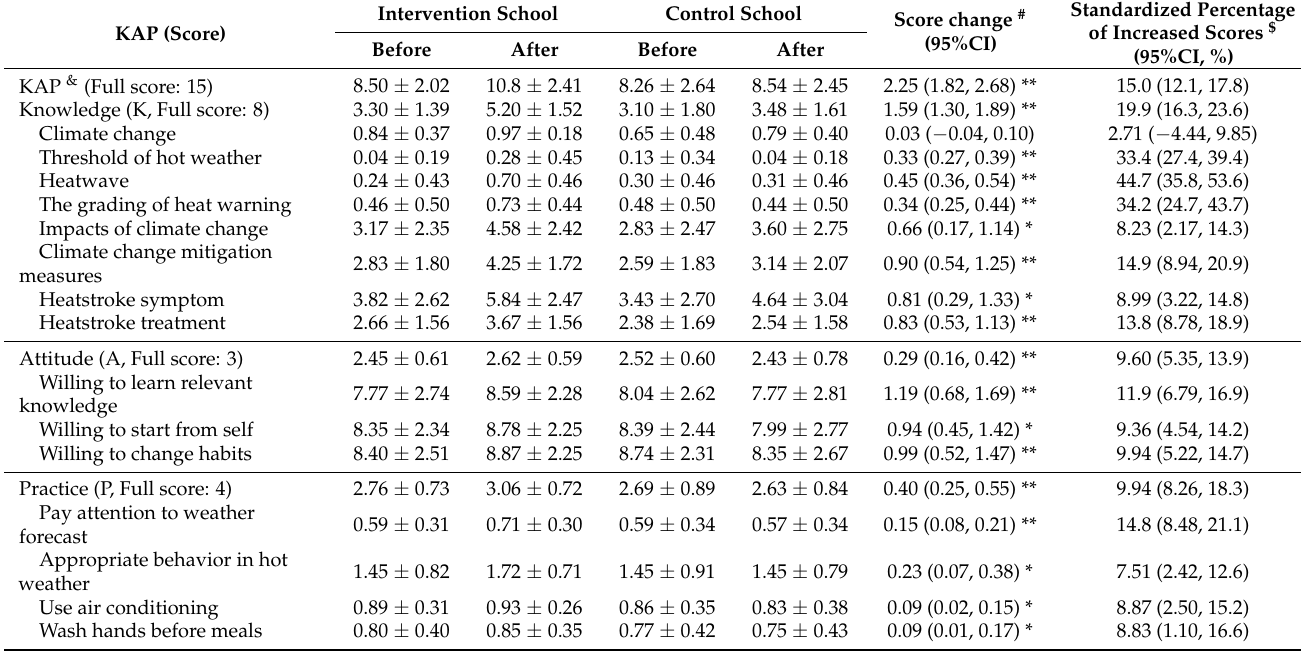
Table 2. Scores for knowledge, attitude, and practice (KAP) for primary students in intervention and control schools before and after intervention and the difference-in-difference (DID) analysis of score